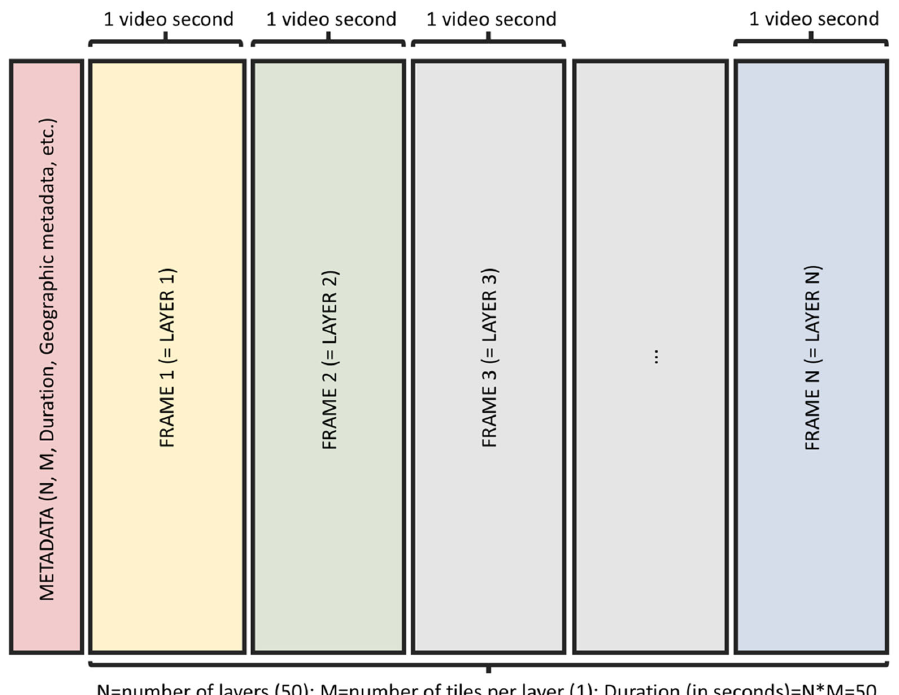
Figure 3. Schematic of a streamable CORE data cube, with metadata at the beginning of the file, followed by one data layer stored inside one frame (at one frame per second).